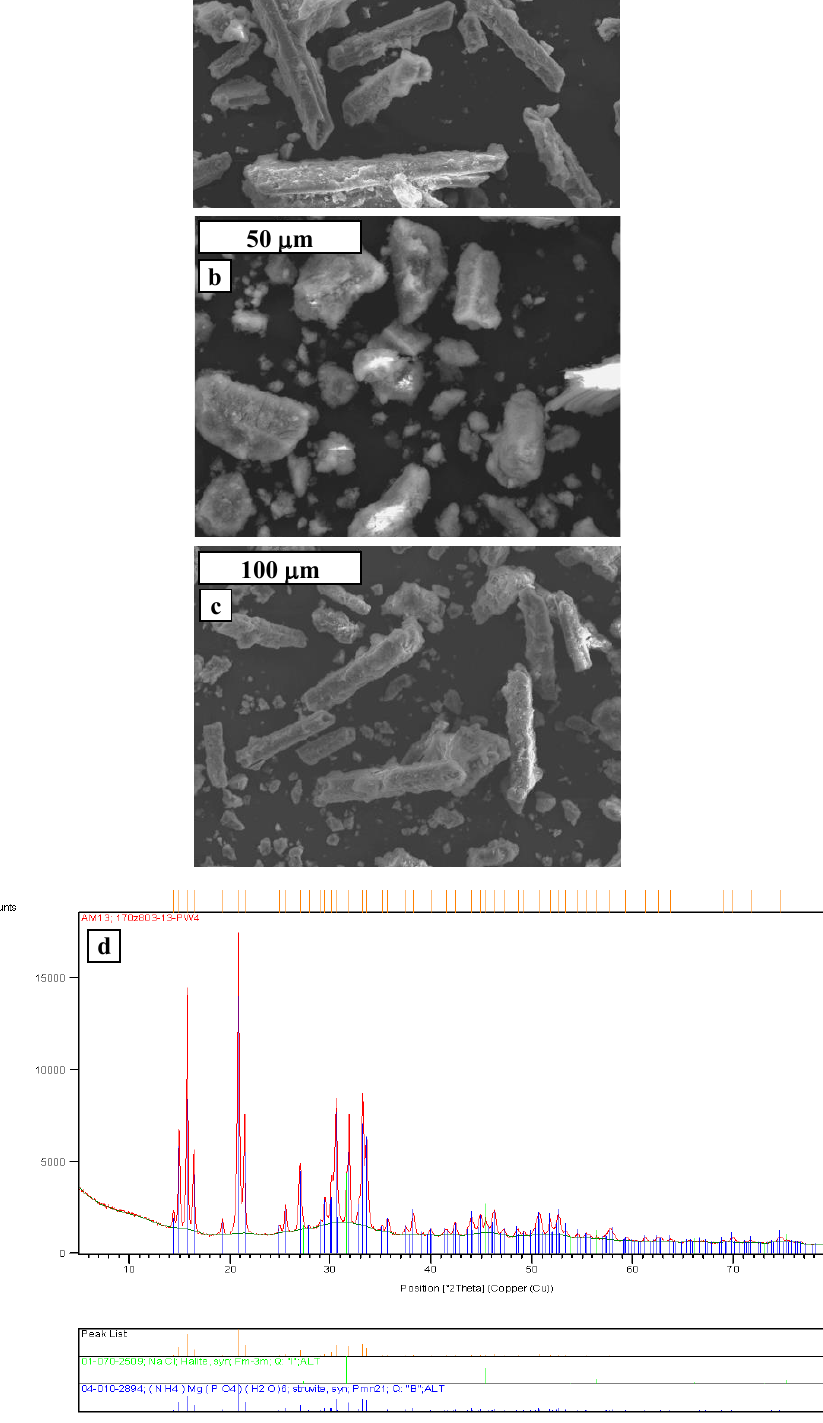
Figure 1: Struvite crystals produced from solution in the presence of: a) calcium ions in synthetic wastewater (experiment No. 6 in Table 1) [11], b) calcium ions in a real cattle liquid manure (CLM in Table 1) [16], c) calcium ions and inorganic impurities in synthetic wastewater [11], d) XRD pattern of crystal product – identification of